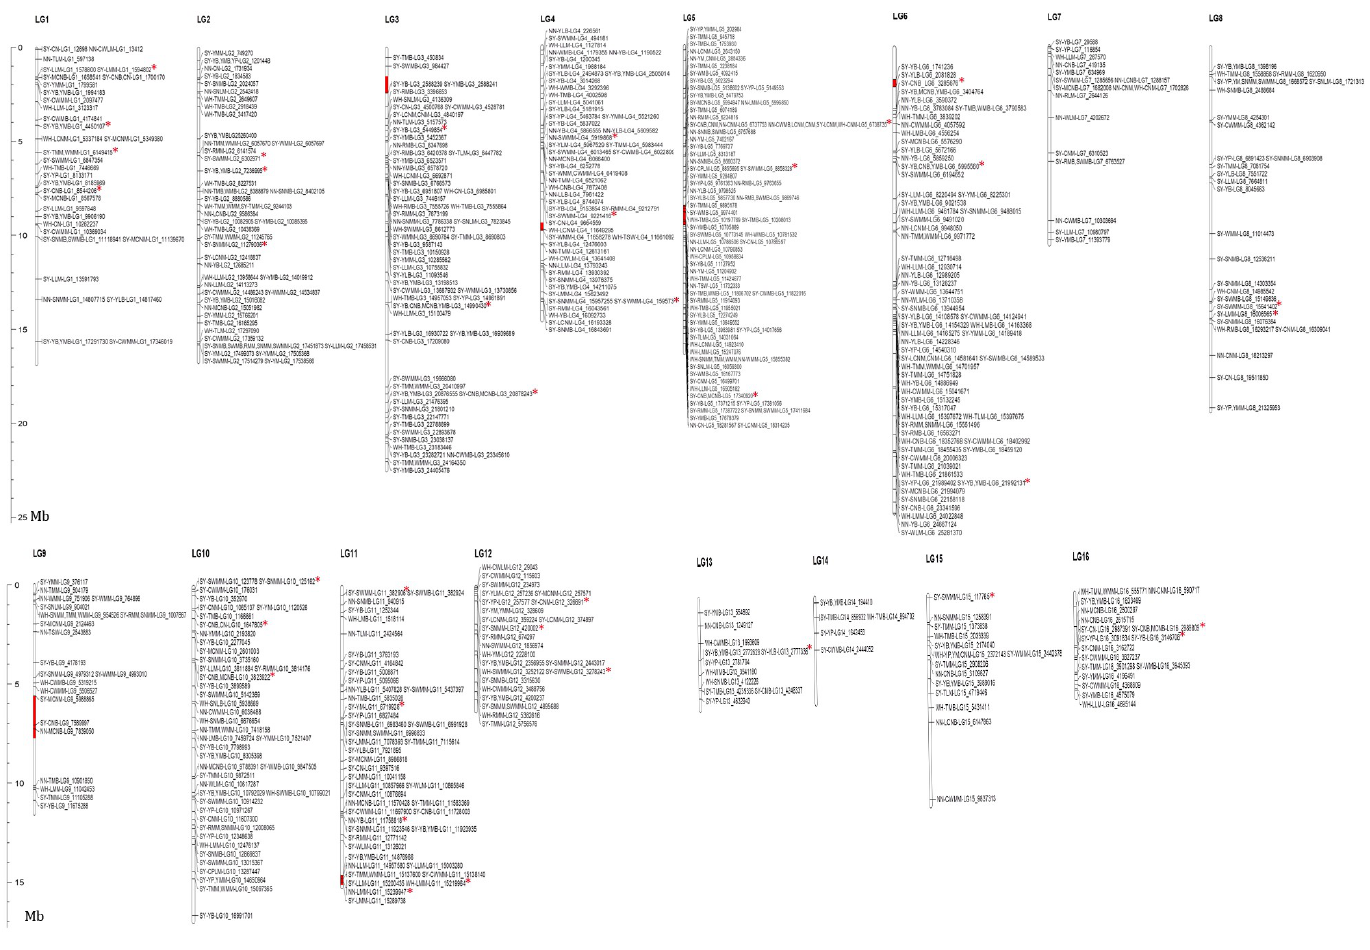
Figure 3. Genomic location of the 547 QTLs identified for seed yield-related traits in sesame. QTLs were named as follow: ENVIRONMENT-TRAIT-LINKAGEGROUP_ POSITION. Bars represent the linkage groups of sesame genome. Red portions of the bars represent the previous QTLs detected by Wu et al. [10]. Red stars represent loci previously detected by Wei et al. [16]. Definition of the labels can be found at the end of this